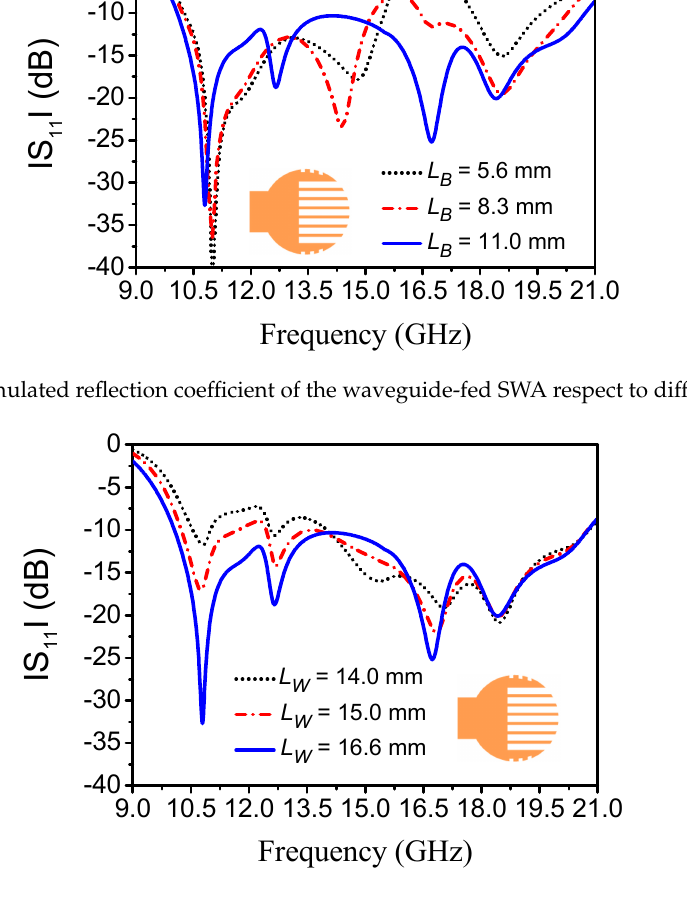
Figure 8. Simulated reflection coefficient of the waveguide-fed SWA as a function of different L W .